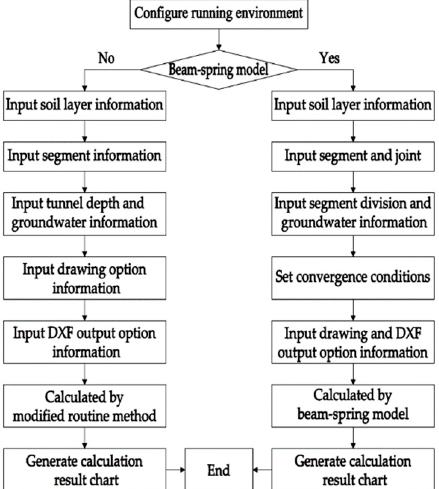
Figure 8. System function structure diagram.